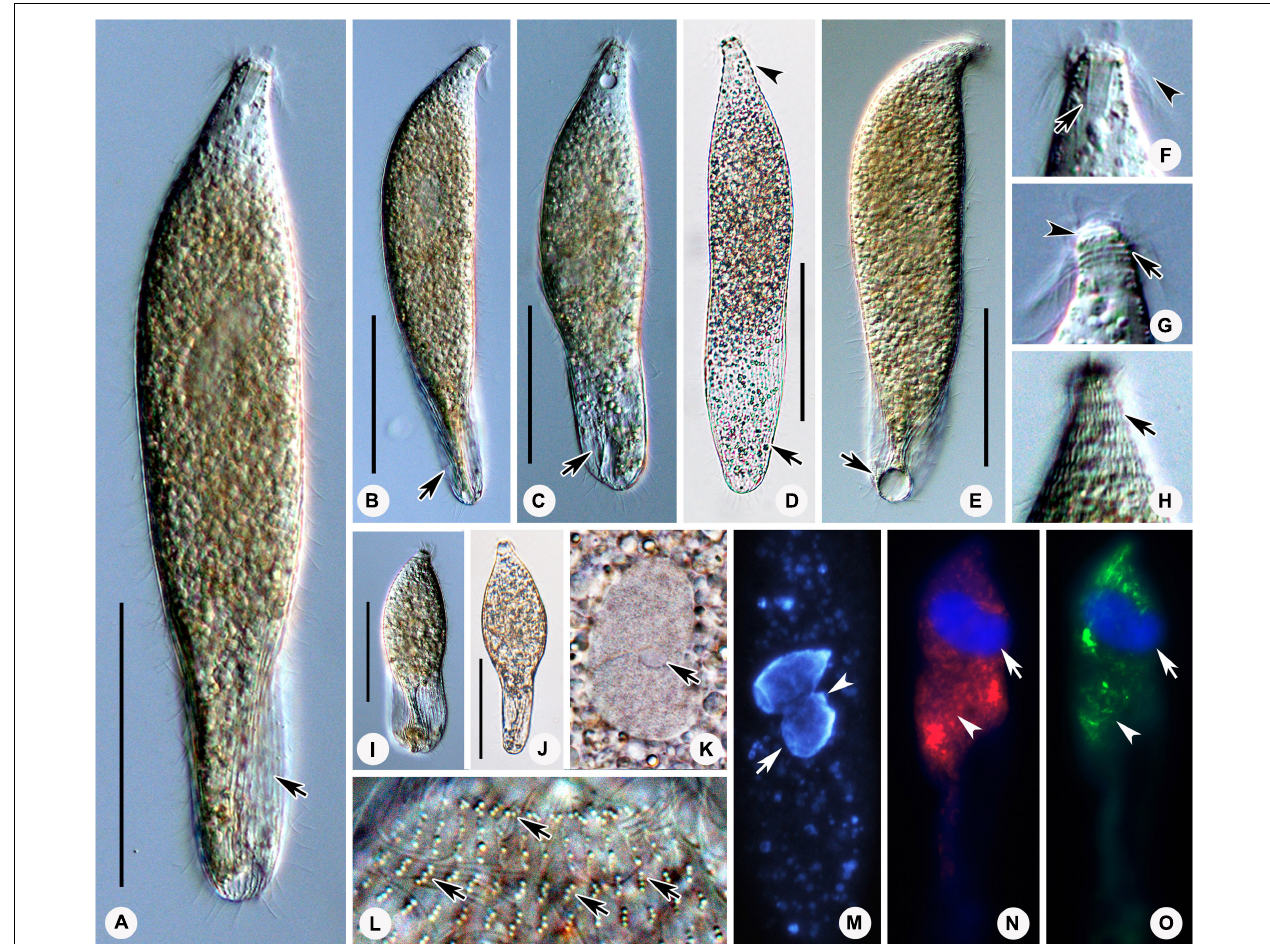
FIGURE 2 | Photomicrographs of Lagynus binucleatus sp. n. in vivo (A–L) , after DAPI staining (M) , and after fluorescence in situ hybridization (FISH) (N–O) . (A) Lateral view of a representative individual, showing the flat posterior end of the body (arrow). (B–D) Shape variants, the flat posterior end of the body at different angles relative to the main body axis (arrows) and furrows in the neck region (arrowhead). (E) The contractile vacuole (arrow). (F) Side view of anterior portion of the cell, showing the nematodesmata (arrow) and perioral cilia (arrowhead). (G) Side view of the anterior portion of the cell, showing annular furrows (arrow) and oral bulge (arrowhead). (H) Side view of anterior portion of the cell, showing the furrows around the neck. (I,J) Showing a smaller individual. (K) The macronuclear nodules and micronucleus (arrow). (L) The cortical granules (arrows). (M) The macronuclear nodules (arrow) and micronucleus (arrowhead). (N,O) The macronuclear nodules (arrows), bacteria (N) , and archaea (O) scattered in the cytoplasm (arrowheads). Scale bars: 70 µ m (A–E) , 90 µ m (I,J)